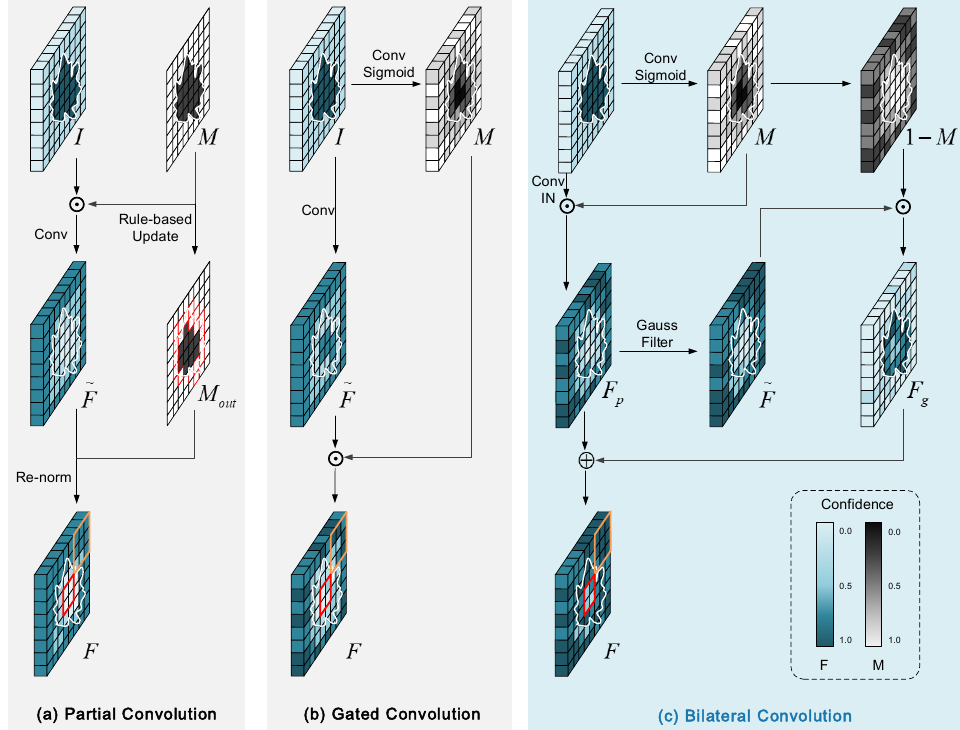
Figure 3. Illustration of Partial Convolution, Gated Convolution, and our proposed Bilateral Convo- lution method. The value of feature F is close to 1, representing a more confident feature. The value of the mask map M is closer to 1, representing greater validity. The middle of the feature map is the damaged hole region, marked with a white